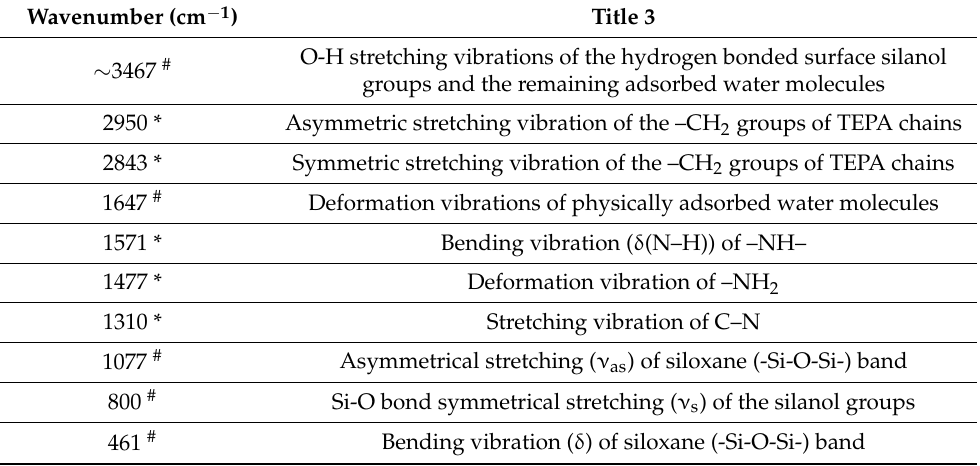
Figure 4. FTIR spectra for ( a ) unfunctionalized MSU-2 and MSU-2 functionalized with TEPA loadings of ( b ) 20 wt%, ( c ) 30 wt%, ( d ) 40 wt%, ( e ) 50 wt%, and ( f ) 60 wt%. Table 2. Characteristic bonds shown in the FTIR spectra of unfunctionalized MSU-2 and TEPA- functionalized MSU-2